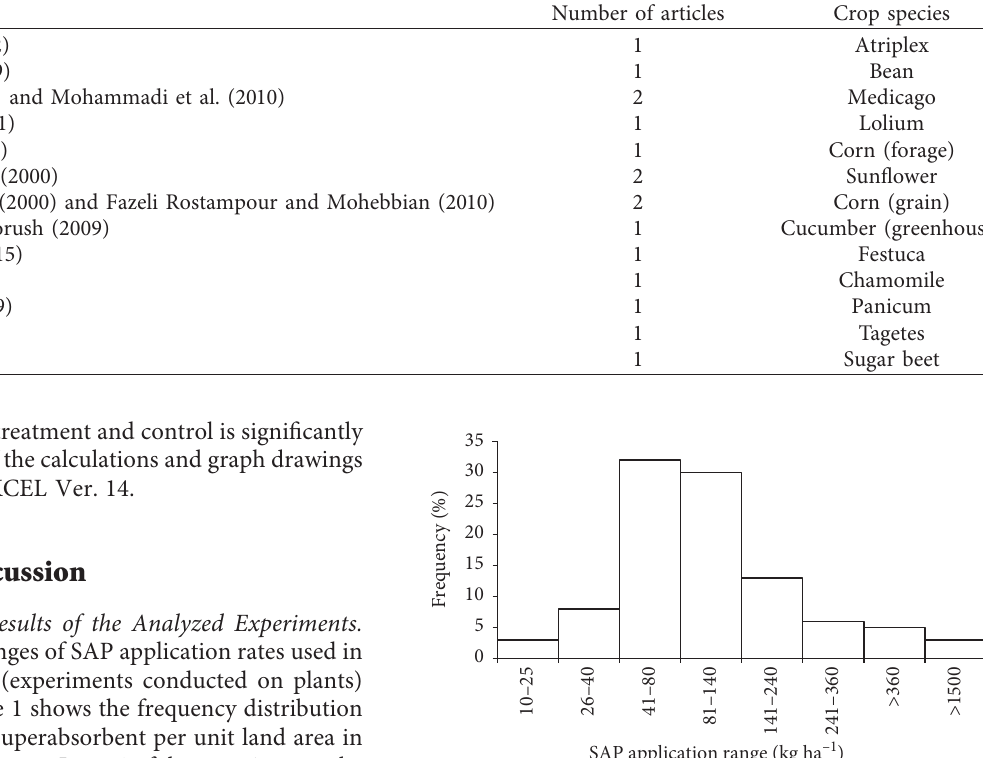
Table 2: Some information on the articles which did not contain the required data and were only partly used in the meta-analysis. Authors